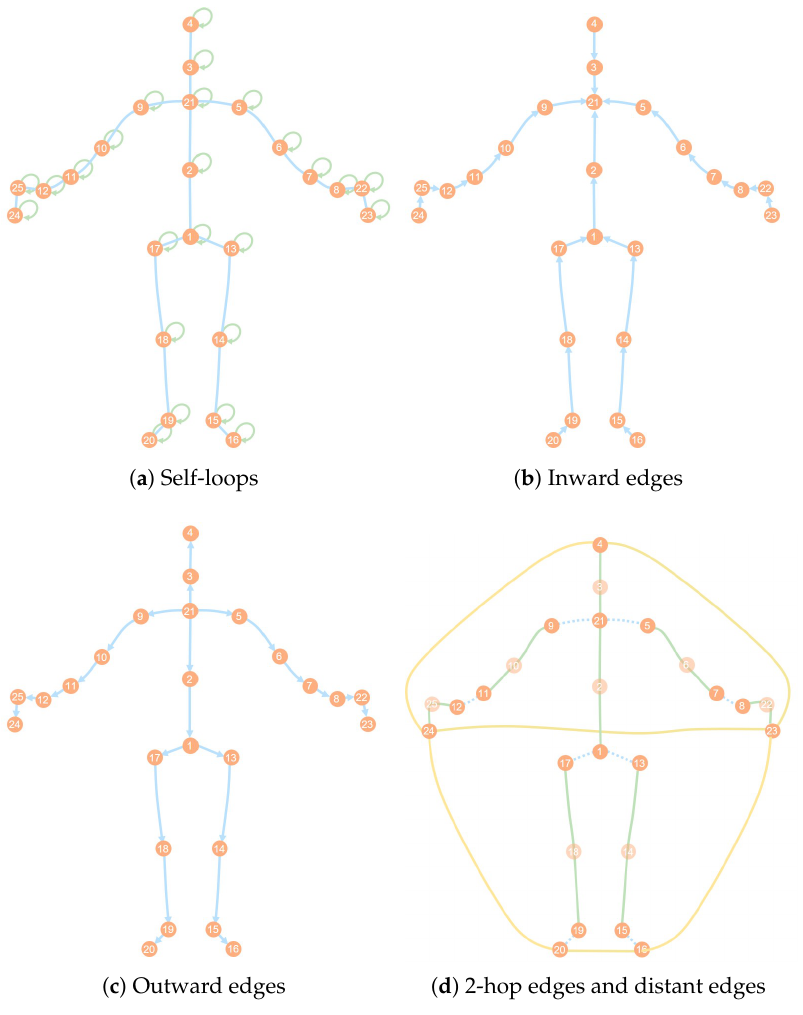
Figure 2. ( a ) The self-loops of each joint. ( b ) Edges whose direction is inward from the center joint. The direction of edges in ( c ) is opposite to ( b ). ( d ) 2-hop edges and the connection of several marginal joints.